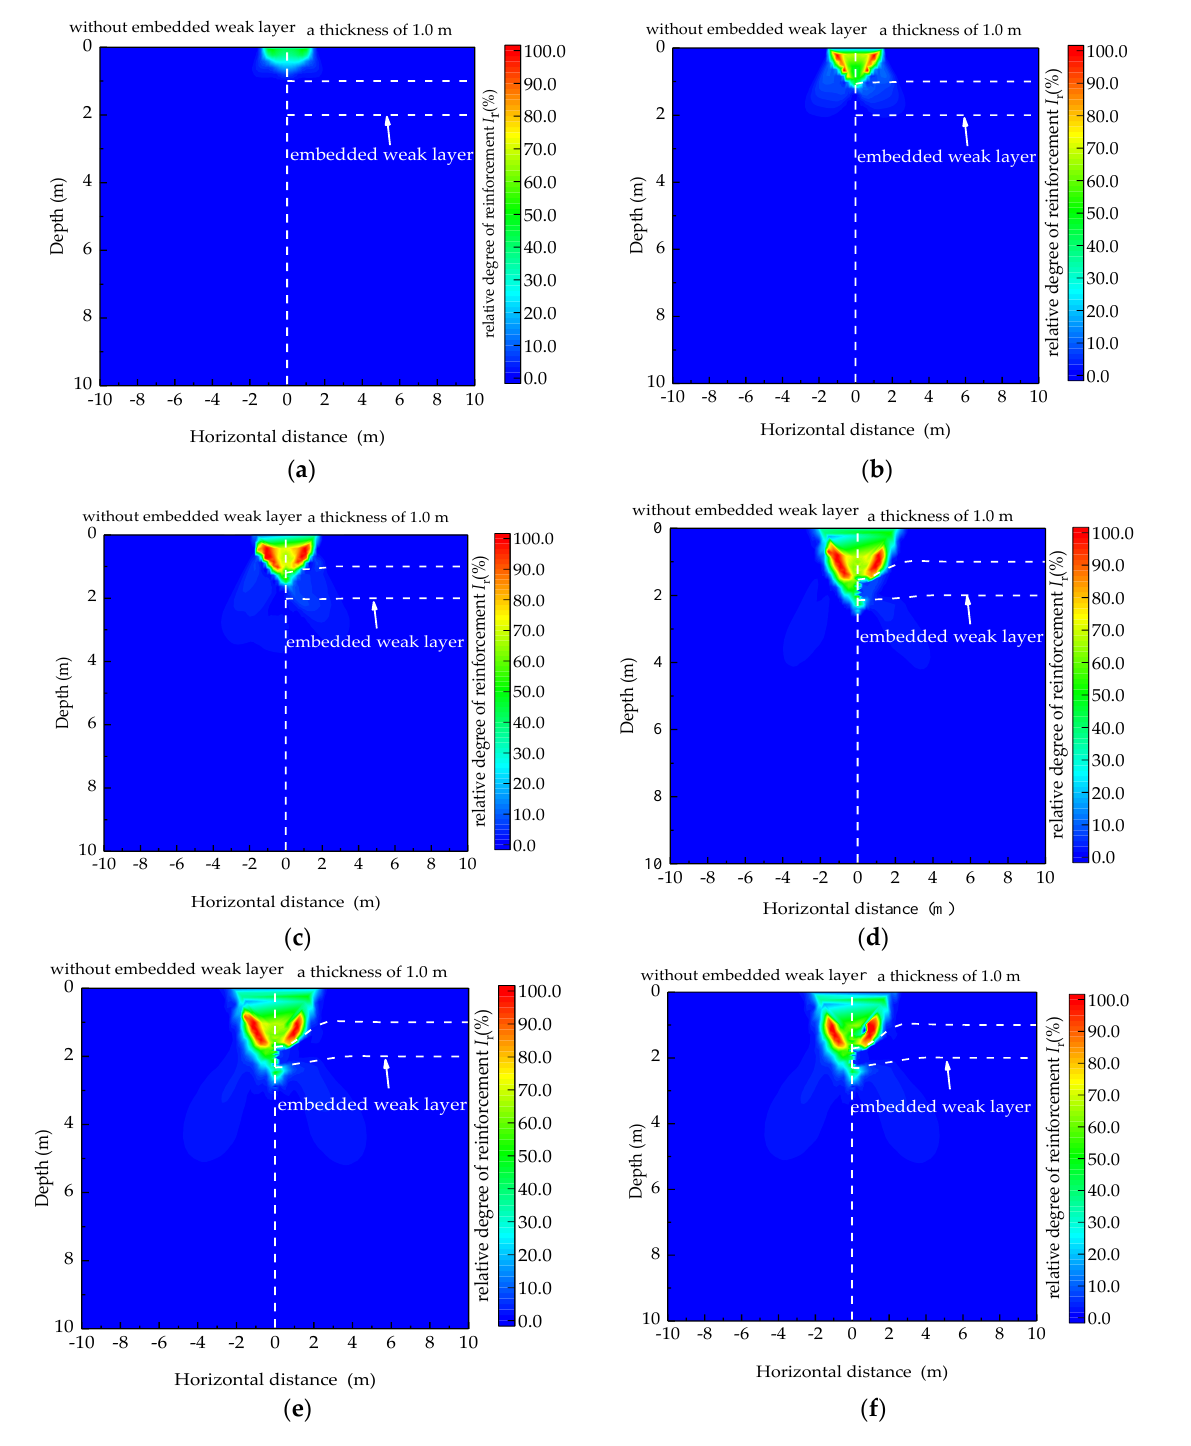
Figure 9. Distributions of I r of foundation with or without an embedded weak layer during the DC. ( a ) t = 0.01 s; ( b ) t = 0.02 s; ( c ) t = 0.04 s; ( d ) t = 0.1 s; ( e ) t = 0.2 s; ( f ) t = 1 s.